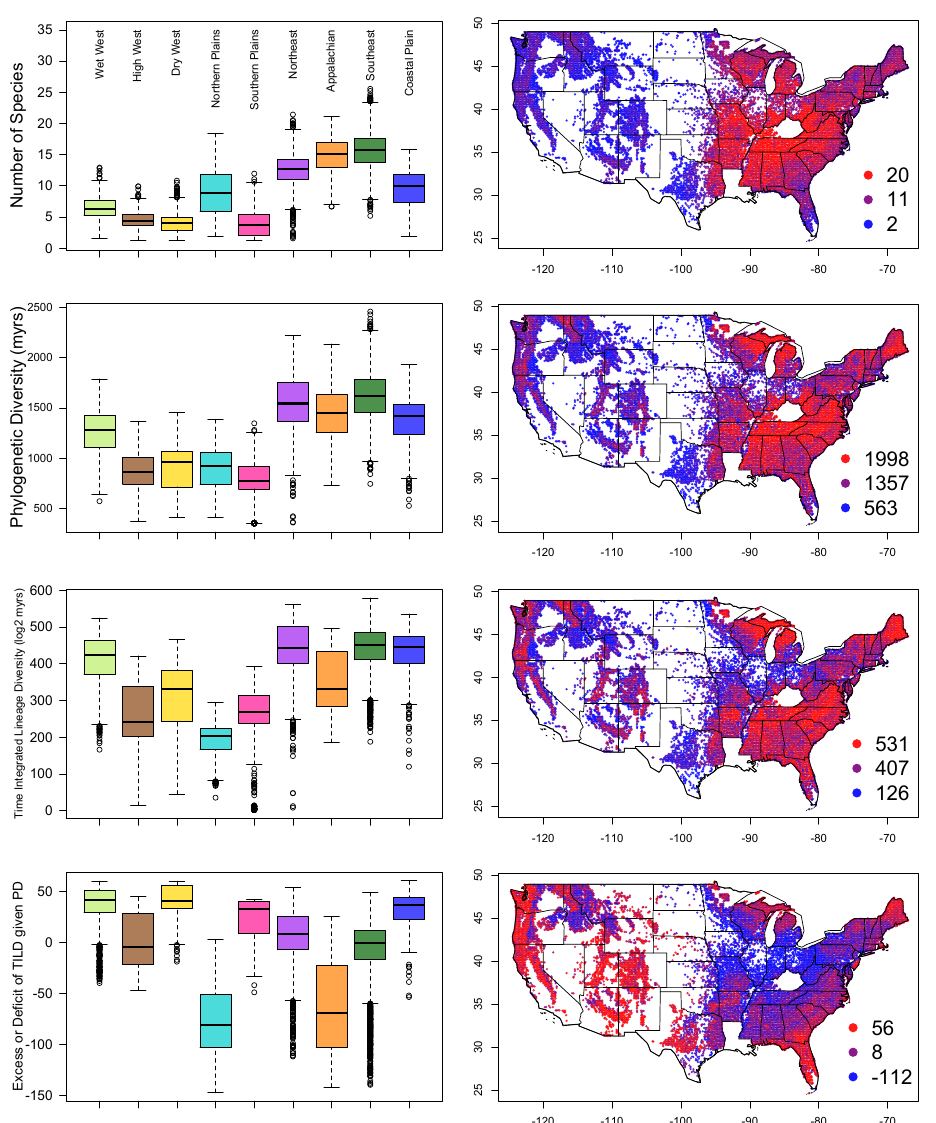
Figure 8. Left: Variation in species richness, phylogenetic diversity (PD), time integrated lineage diversity (TILD) and the excess or deficit of TILD given PD for tree assemblages, separated by major evolutionary group. The latter represent the residuals from a regression of TILD on the logarithm of PD. Values for each assemblage represent the average across 100 rarefactions to 50 tree individuals. Right: Maps of the same metrics, per assemblage, across the contiguous United States, with the colours for the upper 95% quantile, median and lower 95% quantile for a given metric in the lower right-hand corner of each